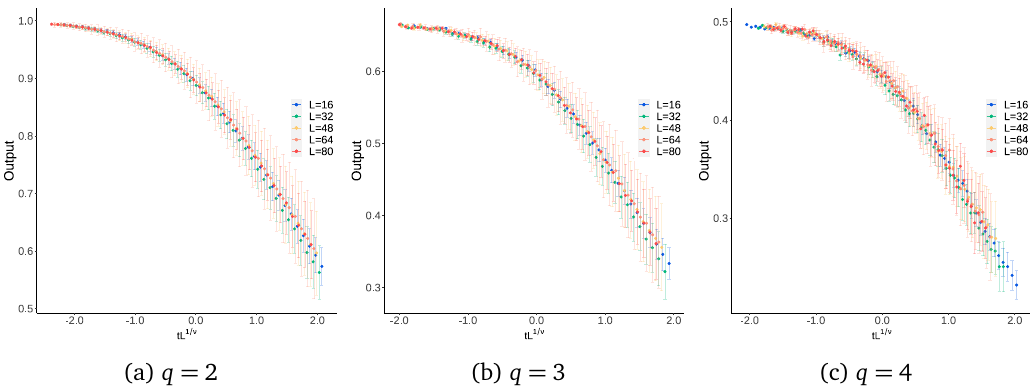
Figure 23: The finite-size scaled plots of the average output of an ensemble of 10 independently trained ANNs – training with simplified data, and testing with MC data of the ferromagnetic q -state Potts model on a triangular lattice. The error bars shown are 99.7% confidence intervals of the ensemble